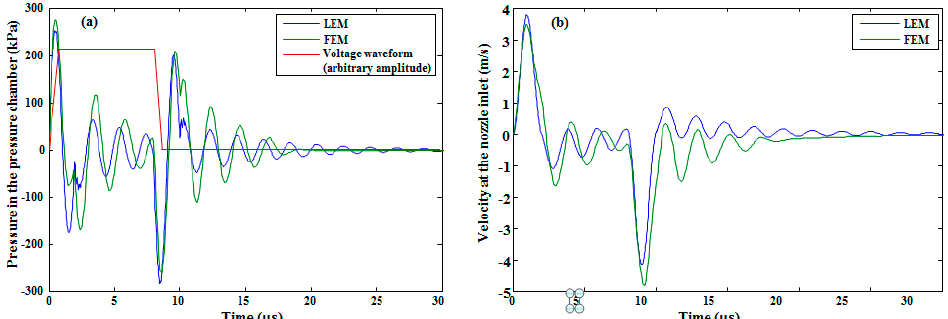
Figure 6. ( a ) Pressure at the pressure chamber and ( b ) velocity at the nozzle inlet.